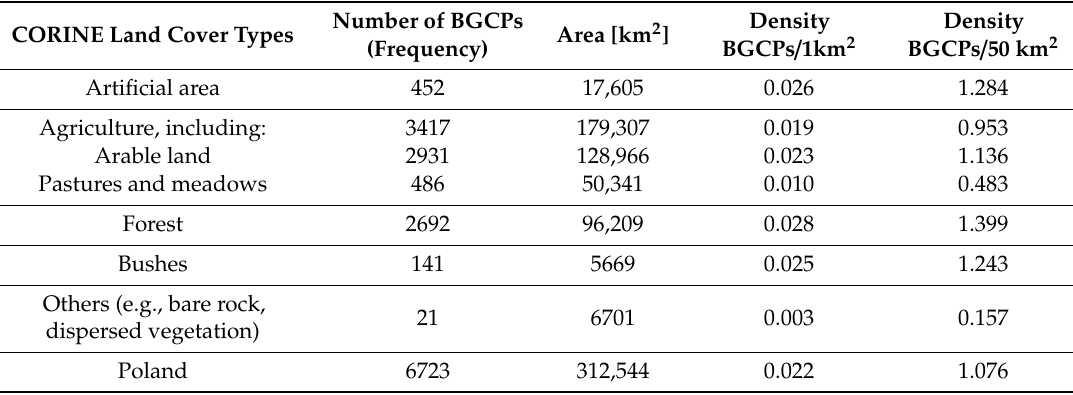
Table 2. Global density of BGCPs over CORINE land cover